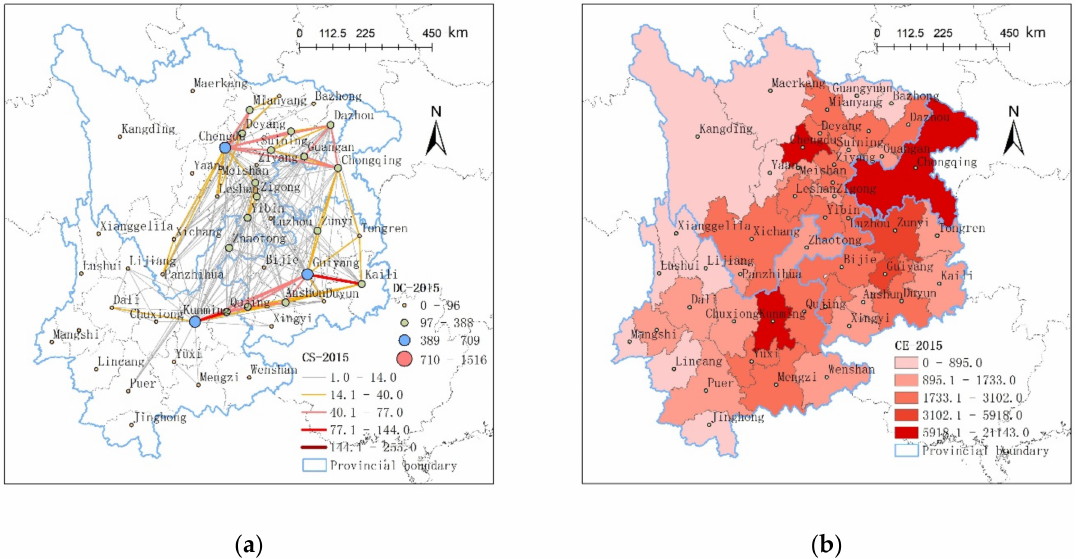
Figure 3. ( a ) Urban networks in southwest China in 2015. ( b ) Carbon emissions in southwest China in